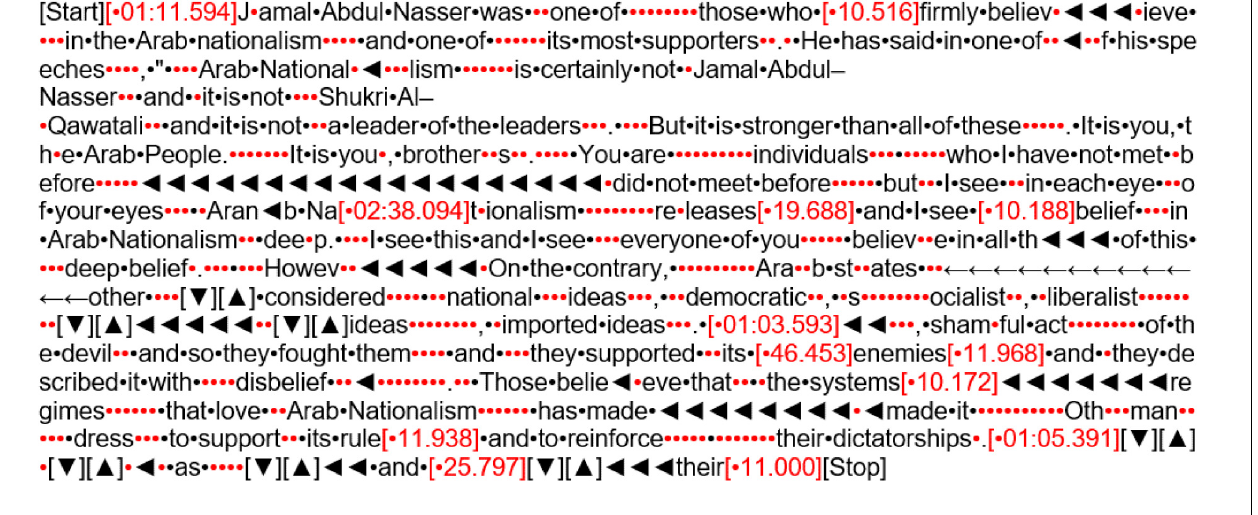
FIGURE 4 | Linear representation of a media text.